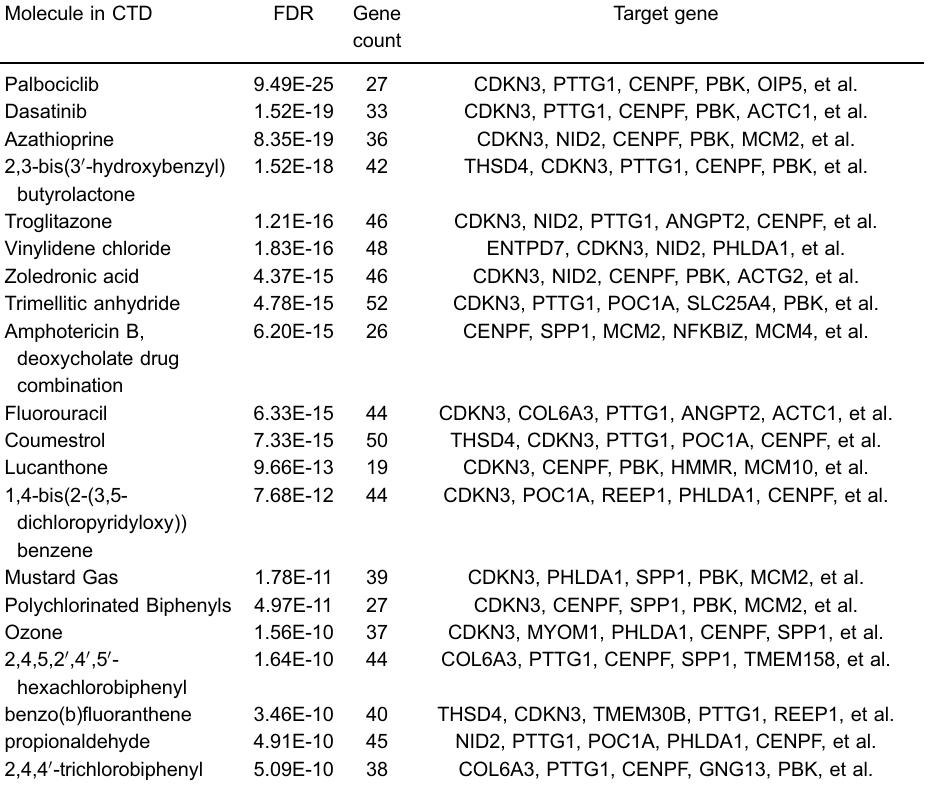
Table 4. Top 20 small molecules of the differentially expressed